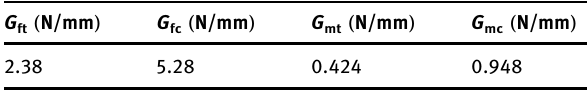
Table 6: Fracture energies of GFRP used for simulations [ 45